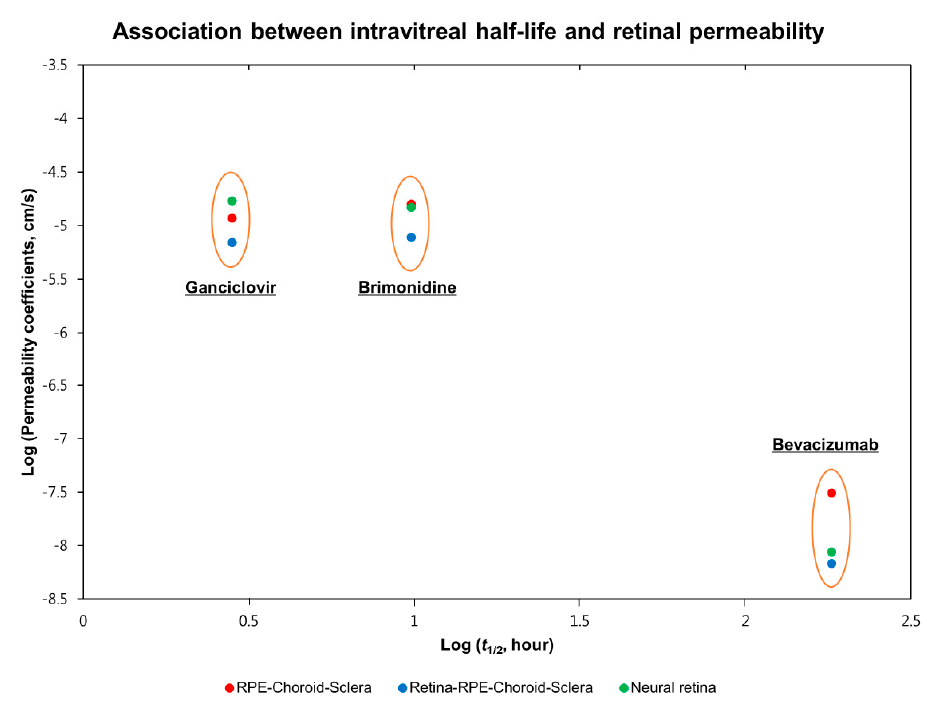
Figure 2. The association between intravitreal half-life and retinal permeability. The experimental data values are documented in Table 2, and then presented as a graph in log scale. Bevacizumab showed low permeability in the ocular tissues due to its high molecular weight compared to brimonidine and ganciclovir.